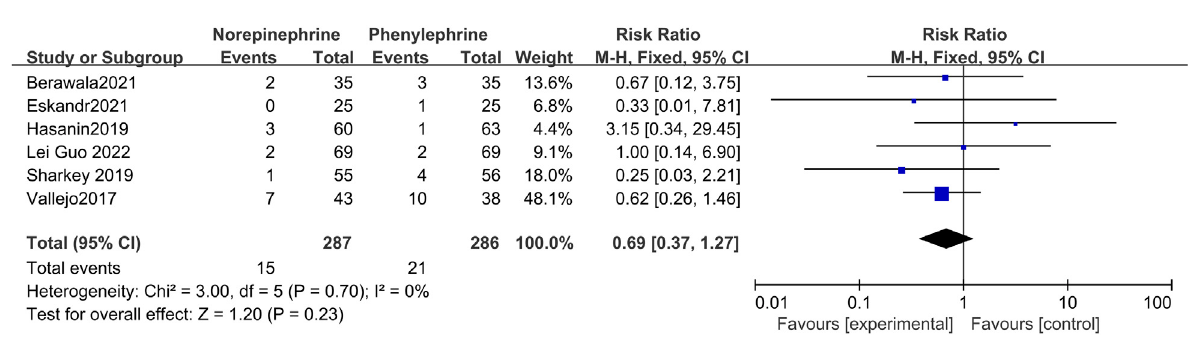
FIGURE 7 Forest plot of the incidence of vomiting comparing norepinephrine with phenylephrine.